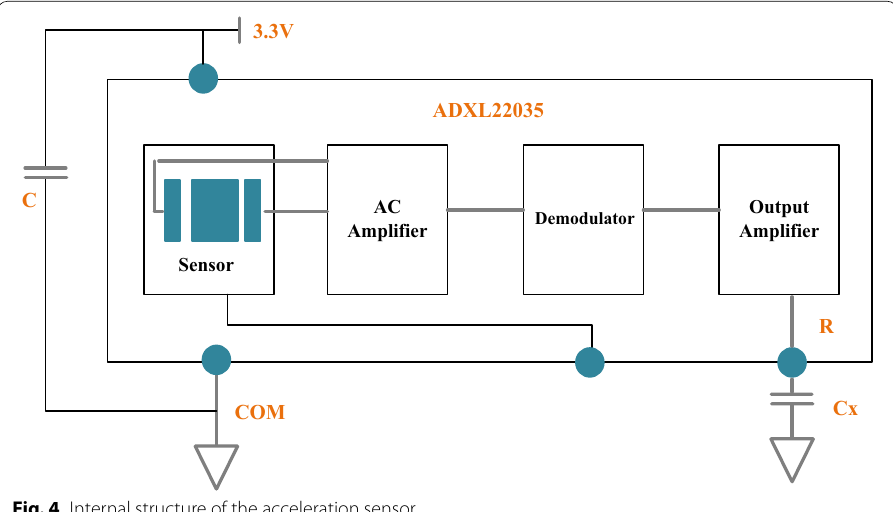
Fig. 4 Internal structure of the acceleration